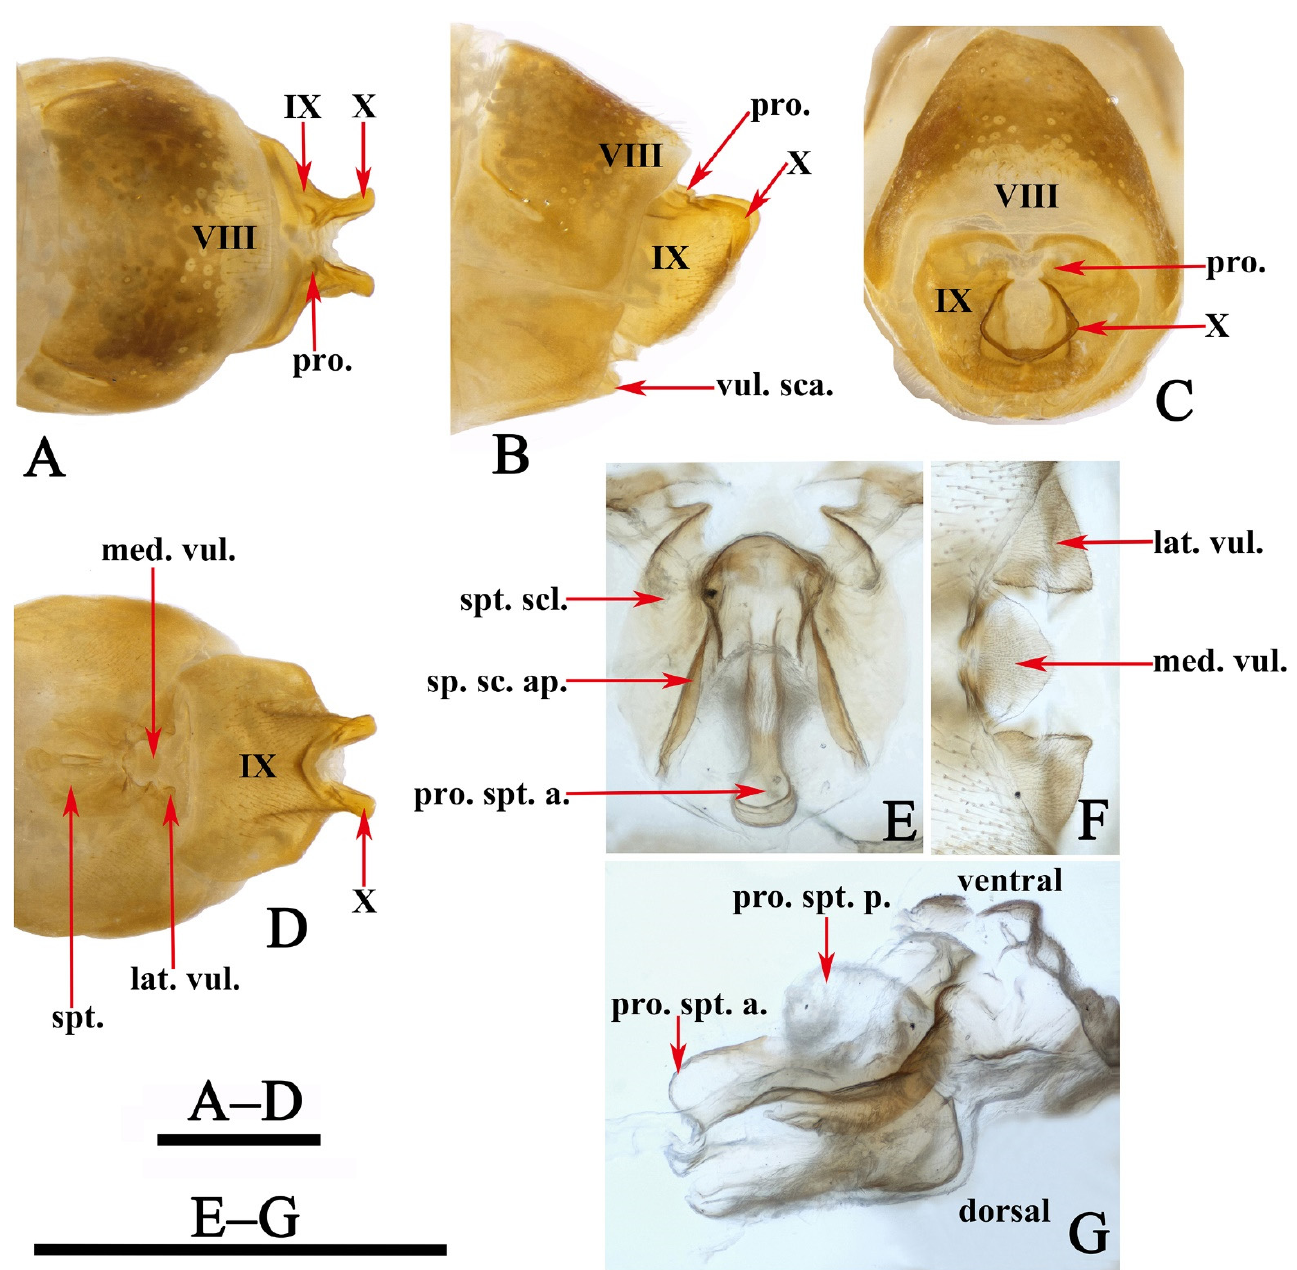
Figure 5. Limnephilus deqianensis n. sp. , female genitalia. ( A ) Dorsal; ( B ) left lateral; ( C ) caudal; ( D ) ventral; ( E ) spermatheca, dorsal; ( F ) vulvar scales, ventral; ( G ) spermatheca, right lateral. Abbreviations: lat. vul. = lateral vulvar lobe (paired); med. vul. = median vulvar lobe; pro. = processus; pro. spt. = processus spermatheca; pro. spt. a. = anterior section of processus spermatheca; pro. spt. p. = posterior section of processus spermatheca; sp. sc. ap. = spermathecal sclerite apodeme. Scale bars: 1 mm.